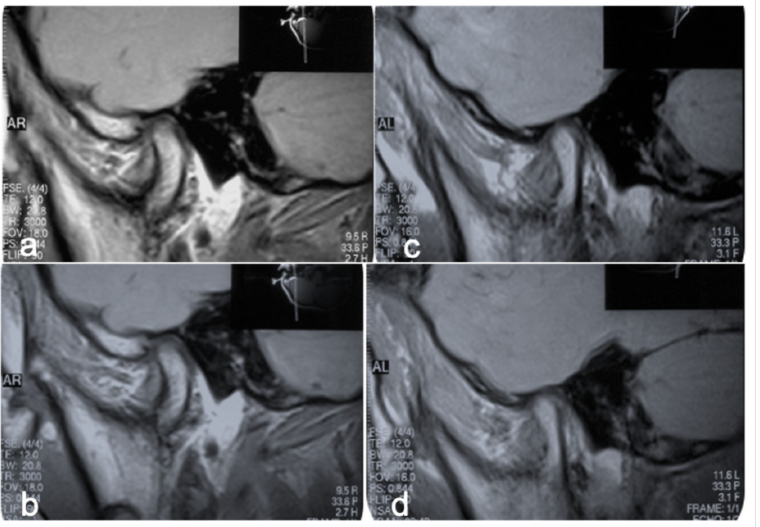
Figure 7. ( a – d ) MRI images: ( a ) right side—closed mouth; ( b ) right side—open mouth; ( c ) left side—closed mouth; ( d ) left side—open mouth (age